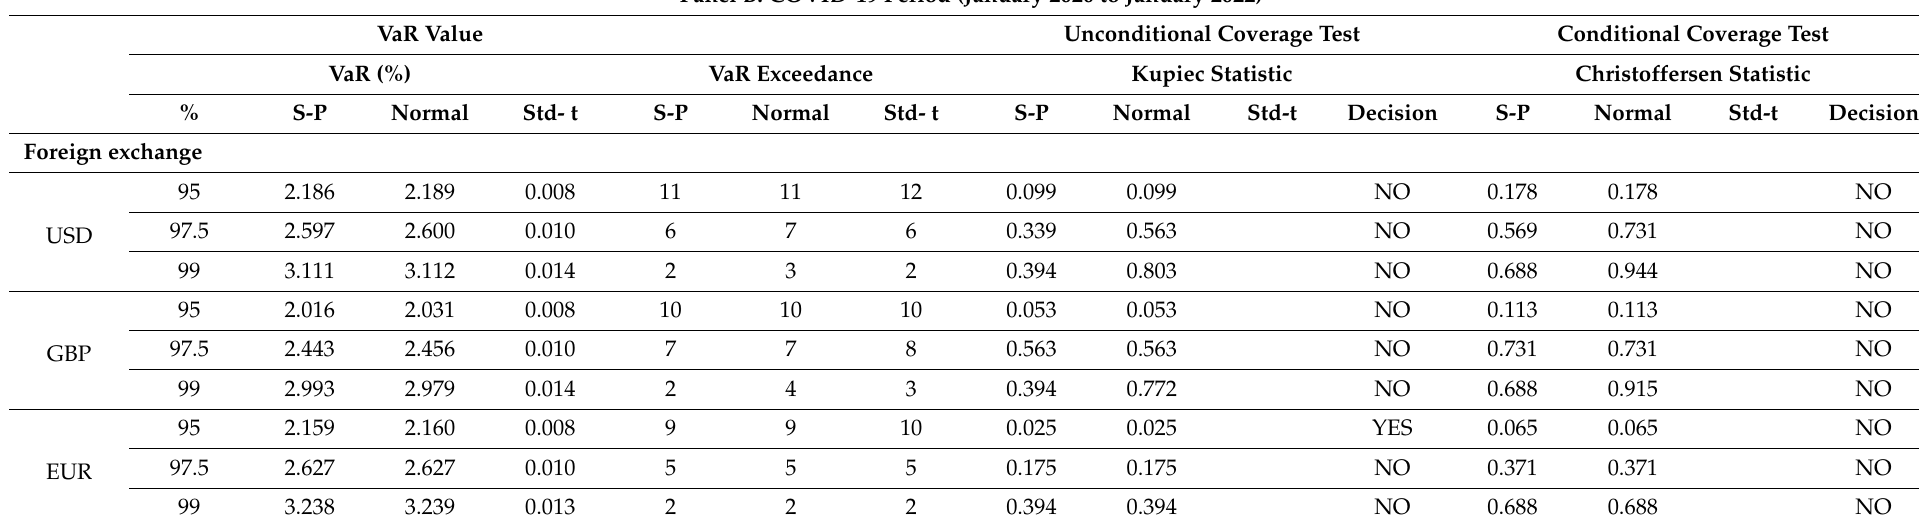
Table 4. Cont. Panel B: COVID-19 Period (January 2020 to January